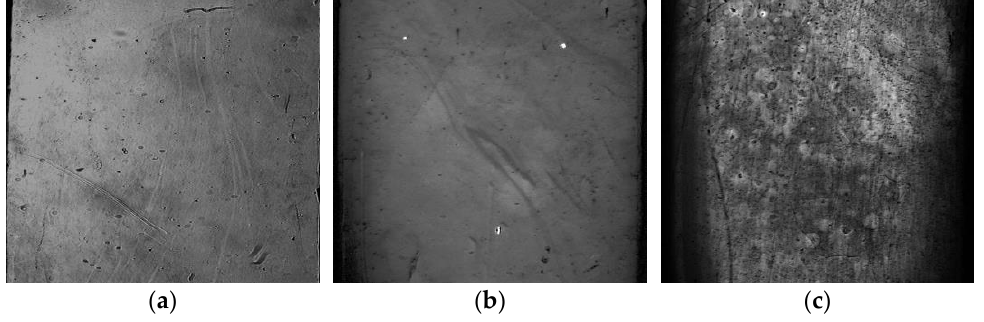
Figure 6. Differential images of the biochip surface after SPRi assays. ( a ) Gold NPs injected onto the POPC/DDAB membrane. ( b ) Gold NPs injected onto the POPC membrane. ( c ) Gold NPs injected onto the POPC/Chol membrane.